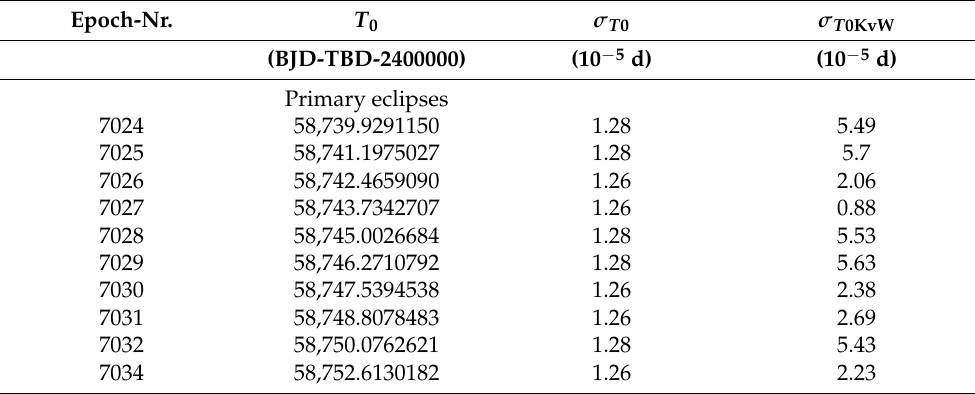
Table A2. Similar to Table 1, but using the KvW method with seven folds.